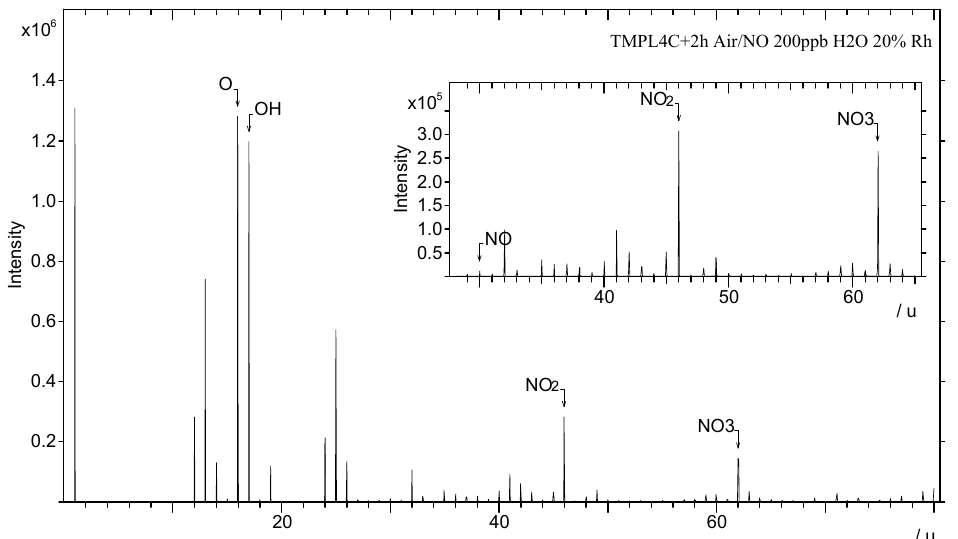
Figure 2. Material + TiO 2 + UV + NO/Air/20% Rel. Humidity, after the analysis with TOF-SIMS. The sample clearly shows peaks assigned to NO 2 (mass 46) and NO 3 (mass 62) in mass/unit [12].